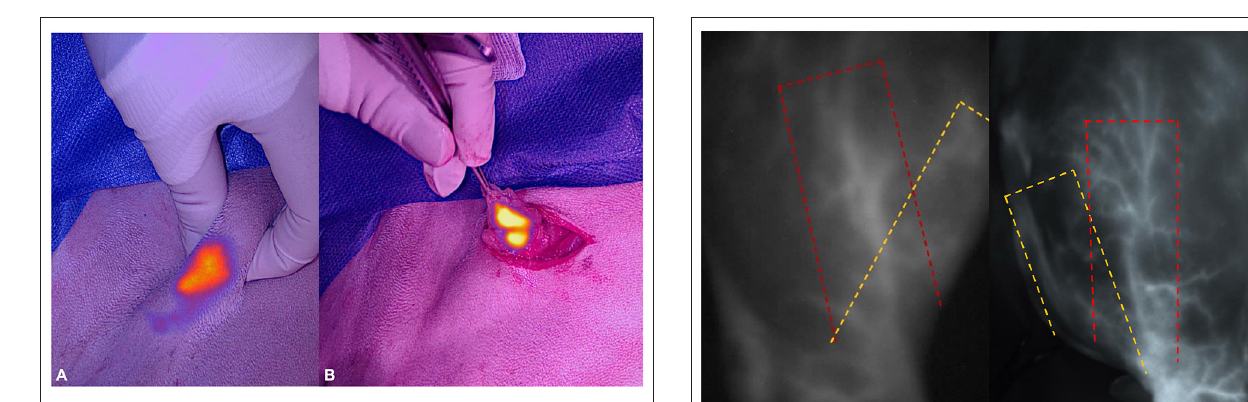
FIGURE 3 | Photographs of the near-infrared signal of the superficial cervical lymph node of dog 2 before (A) and during excision (B) under ambient light. near infrared camera, and the flap was sutured into the defect. A bandage incorporating the shoulder was applied. Surgery time was 89 min.